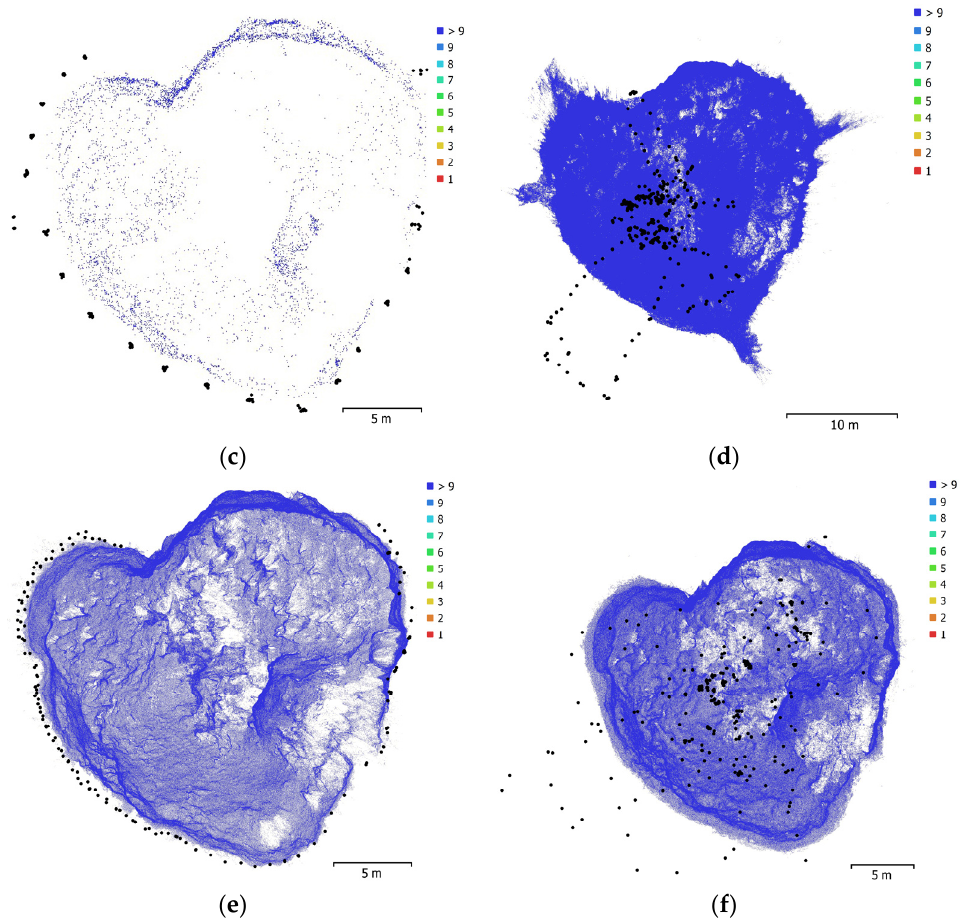
Figure A1. ( a ) 2017 point cloud from terrestrial imagery, ( b ) 2017 point cloud from aerial imagery, ( c ) 2018 point cloud from terrestrial imagery, ( d ) 2018 point cloud from aerial imagery, ( e ) 2019 point cloud from terrestrial imagery and ( f ) 2019 point cloud from aerial imagery. ( a – e ): Camera positions and image overlap as resulting from the Agisoft Photoscan 3D reconstruction and project report. The black dots give the camera position. The colors describe the number of overlapping images.